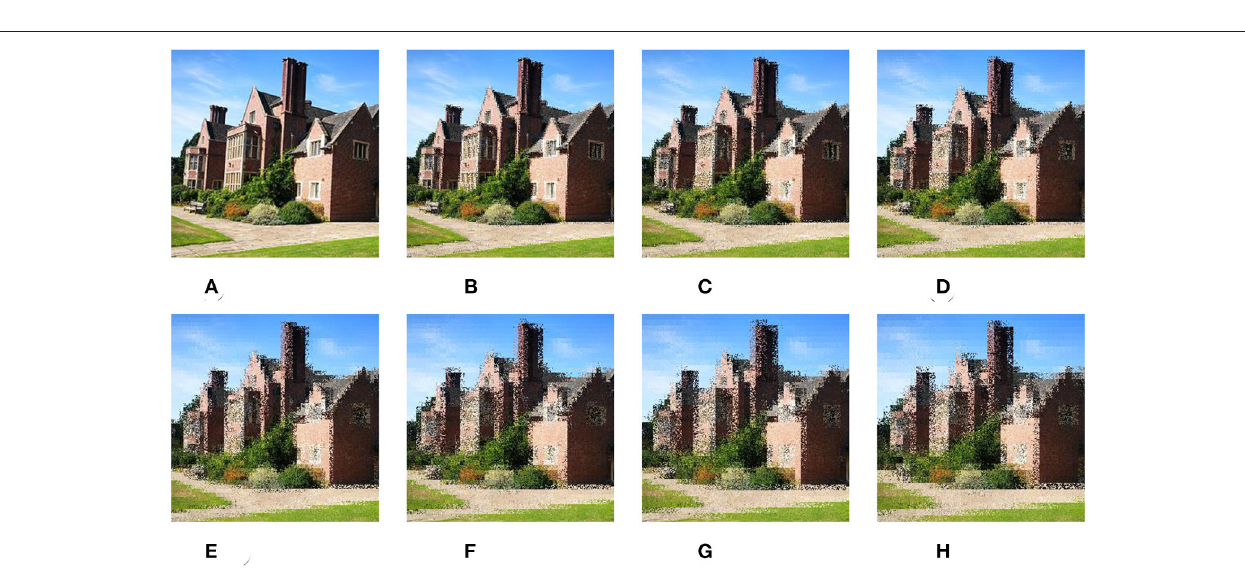
FIGURE 8 | Results of PS on a color image. (A) Raw image. (B) q = 2. (C) q = 3. (D) q = 4. (E) q = 5. (F) q = 6. (G) q = 7. (H) q =